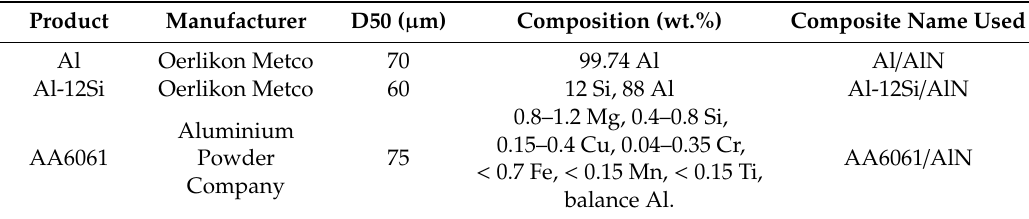
Table 1. Composition and size of the alloy powders